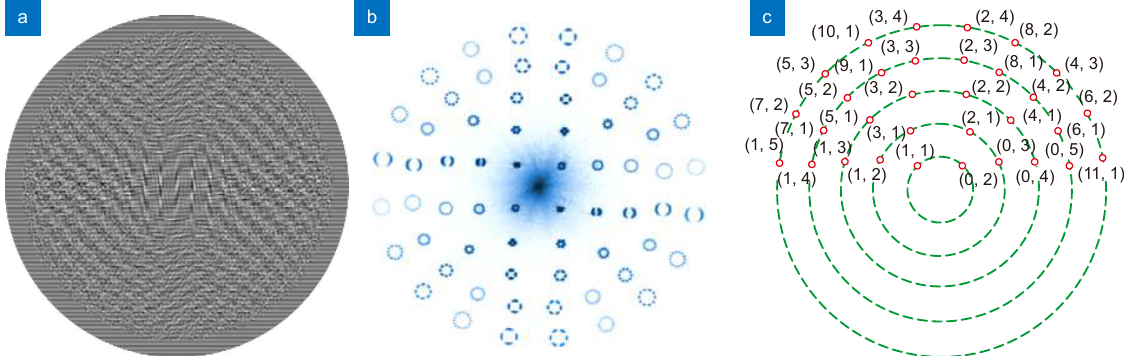
Fig. 21 | ( a ) The binary phase of the encoded 64-order DOE, matched with LP modes of a step-index FO. ( b ) The experimentally recorded in- tensity distribution in the focal plane of the lens when the DOE is illuminated by a plane wave. ( c ) The arrangement of LP-modes indices , (the conjugate modes with indices are located symmetrically in the lower part). Figure reproduced with